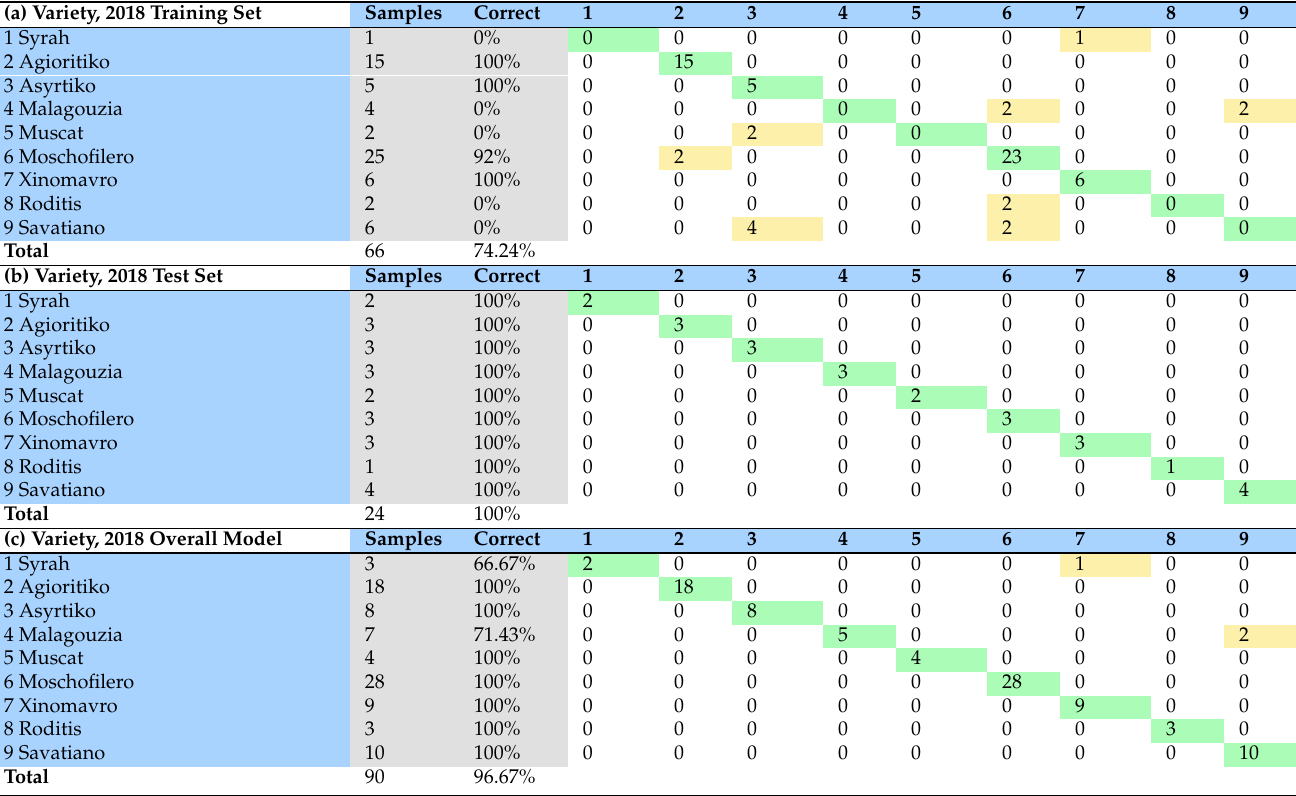
Table 6. Misclassification tables produced for the OPLS-DA models of the wine samples of 2018 classified regarding variety, where ( a ) training set, ( b ) test set, ( c ) overall model.